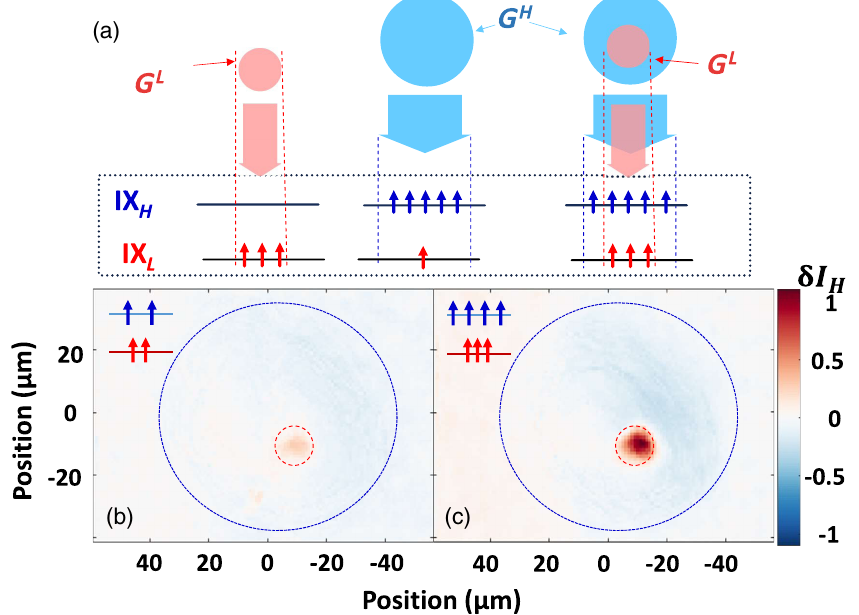
FIG. 3. Optical detection of inter-DQW interactions. (a) Excitation schemes used in the experiments. IX clouds with different diameters are resonantly excited by lasers beams G L and G H tuned to the direct exciton transitions DX L and DX H of the DQWs. The emission from IX in the two DQWs is spectrally analyzed and detected with spatial resolution. (b),(c) Maps of the relative change δ I x; y Þ in the PL intensity of an IX H ð H cloud induced by a narrow IX L cloud (marked by the dashed circle) for a fixed estimated IX H densities at the center of G H of (b) 2 . 1 × 10 10 and (c) 4 . 6 × 10 10 cm − 2 ,